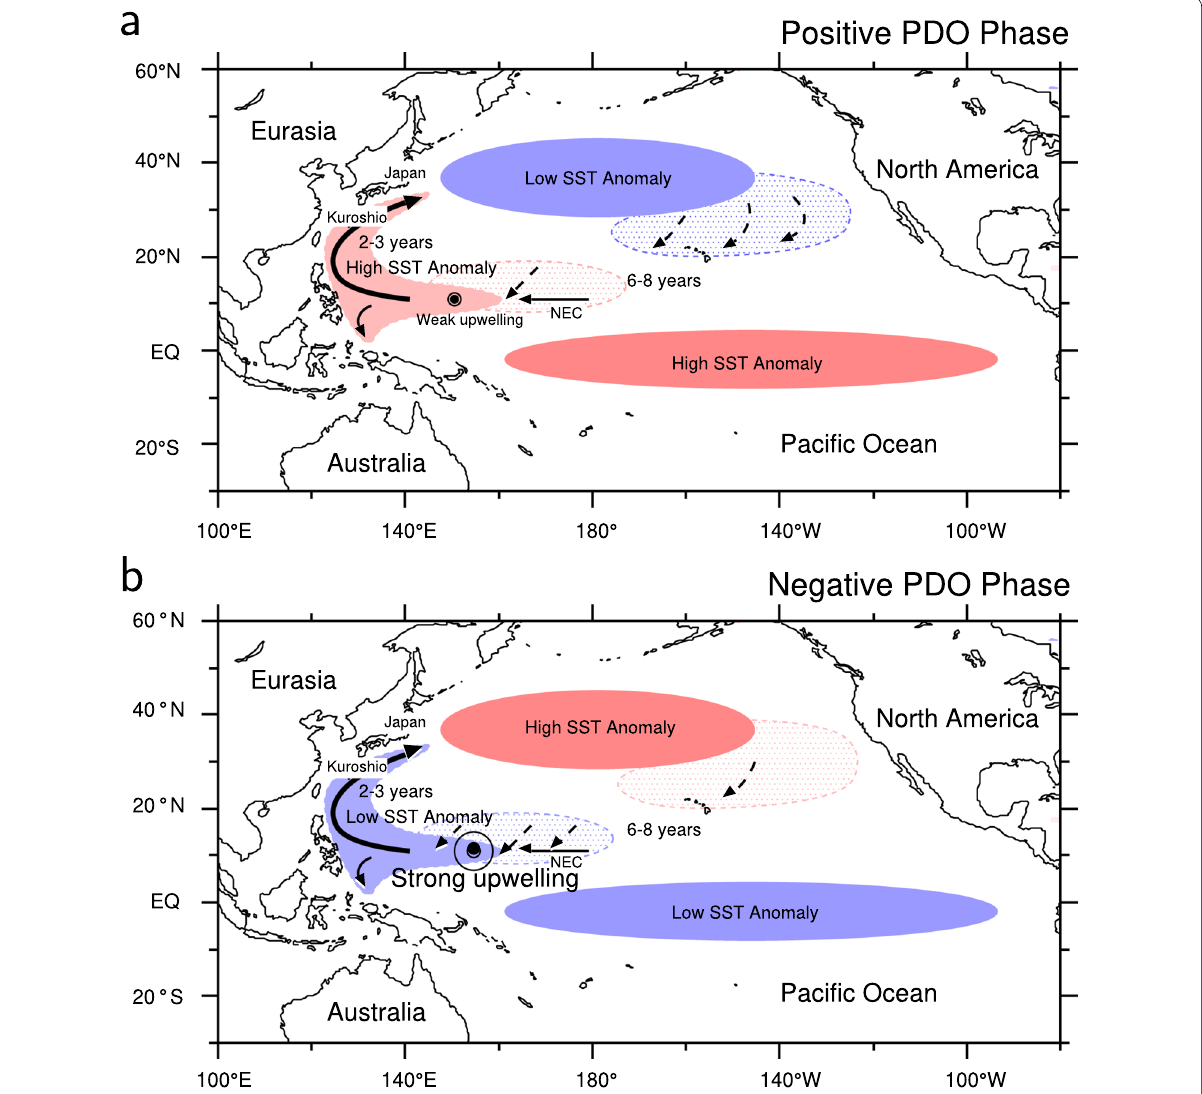
Fig. 17 Schematic representation of the upwelling strength in the NEC region and temperature anomalies in the a positive and b negative PDO phases. SST anomalies are denoted by solid shades and subsurface temperature anomalies dotted shades. High and low temperature anomalies are colored red and blue, respectively. The sea surface Kuroshio and Mindanao currents are illustrated by solid arrows and the subsurface subtropical gyre interior currents dashed